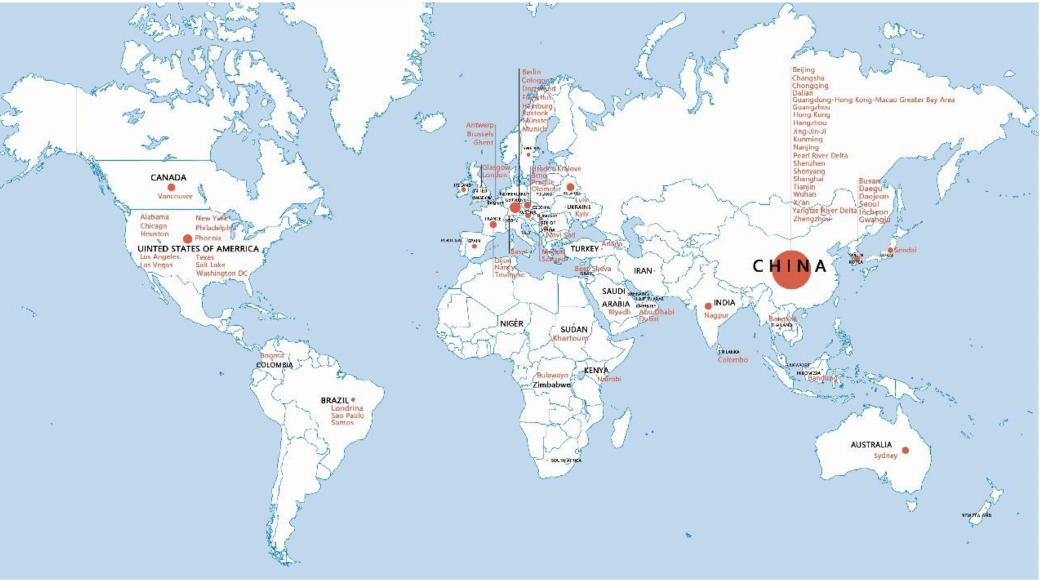
Figure 4. Geographic distribution of LCZ studies. The size indicates the number of articles originating from that country.